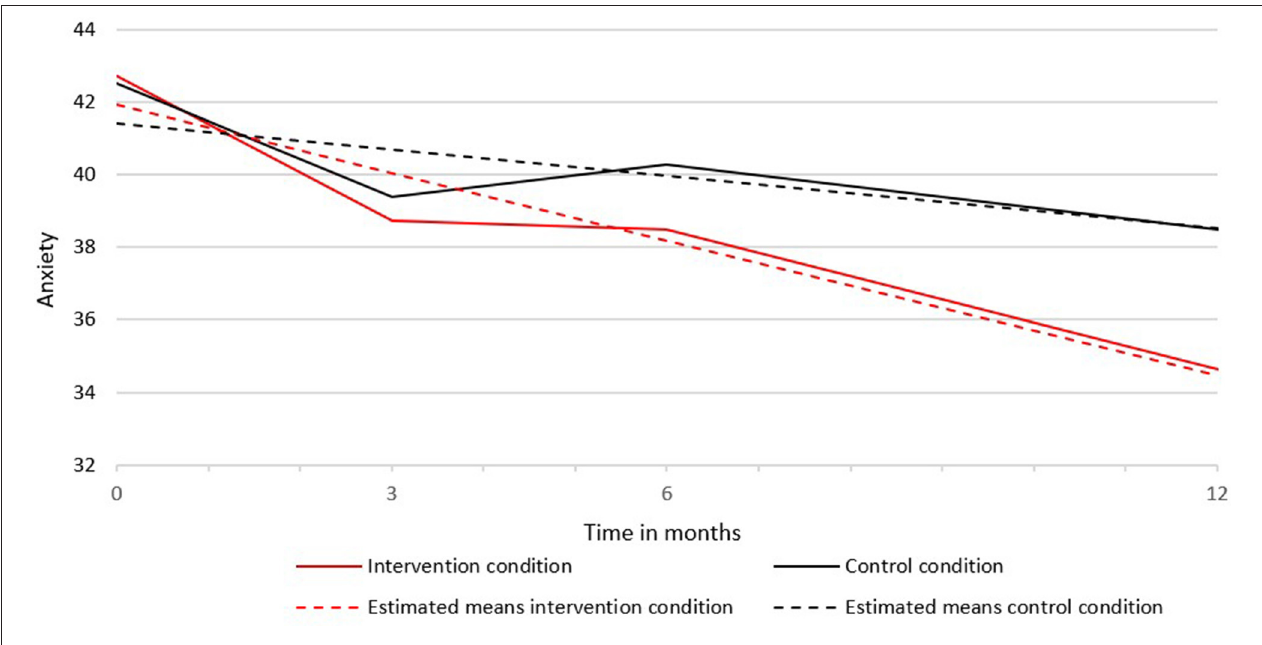
FIGURE 1 | Mean scores of anxiety over time in the intervention and control